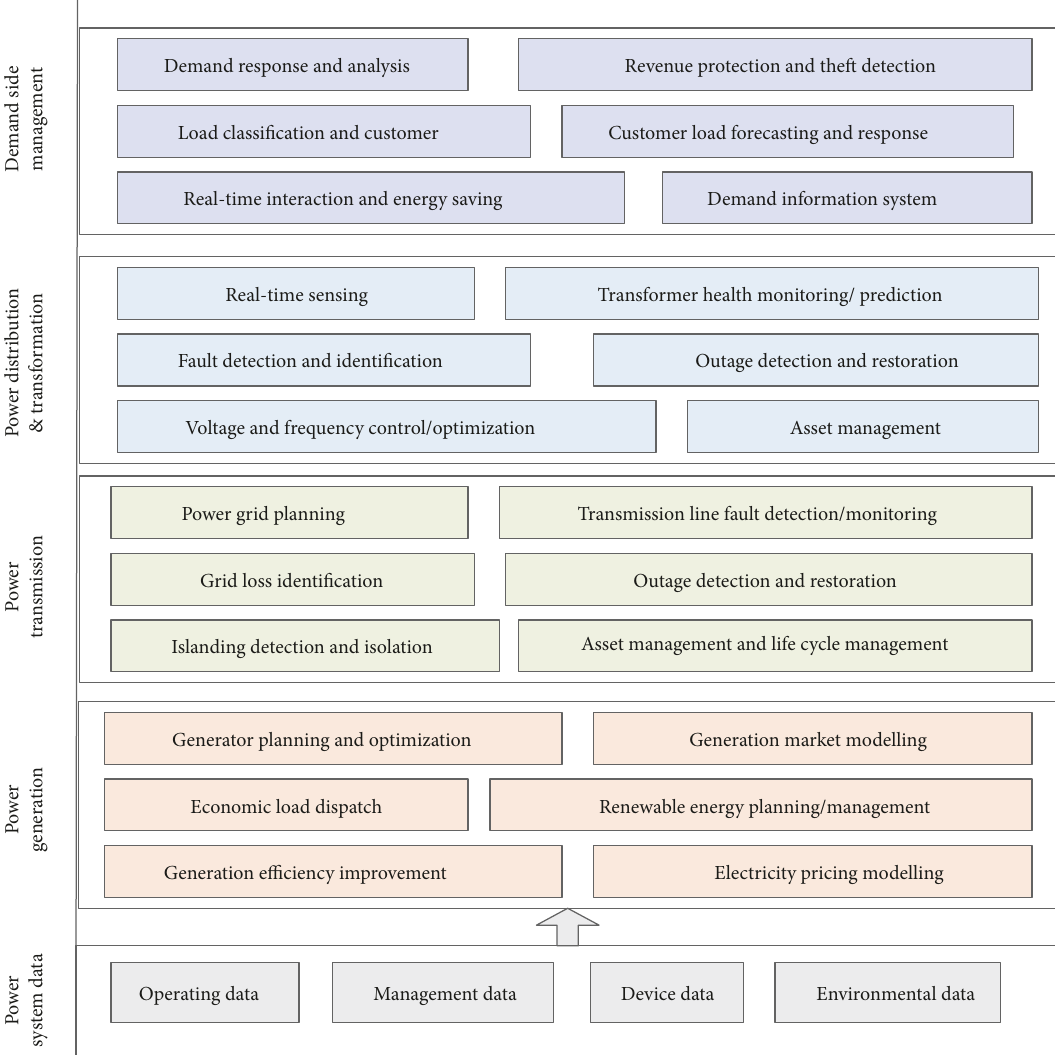
Figure 2: Sketch map of Big Data supporting whole process of the power